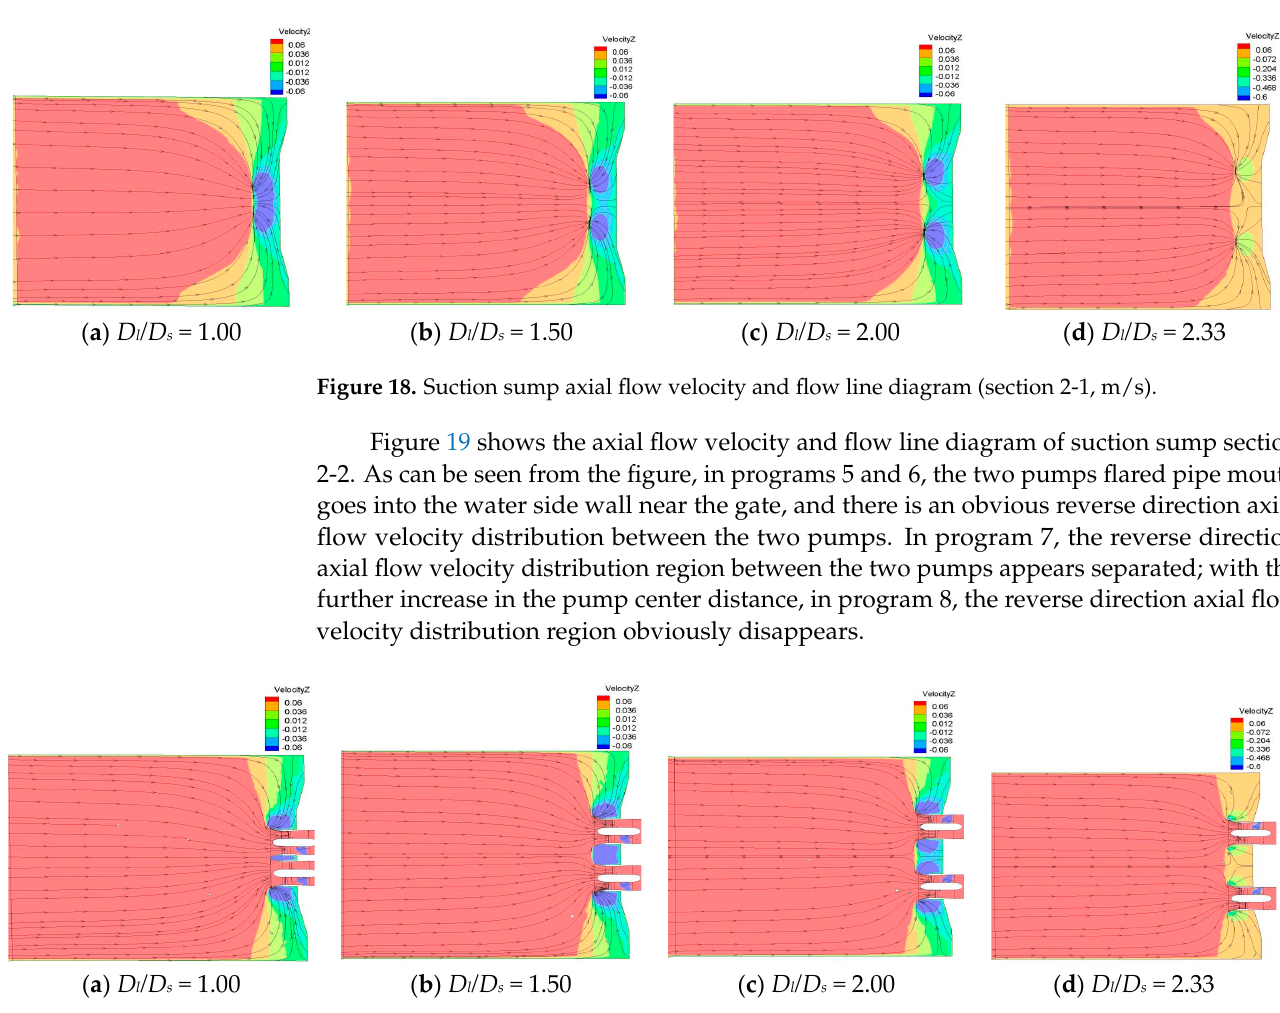
Figure 19. Suction sump axial flow velocity and flow line diagram (section 2 - 2, unit: m/s).